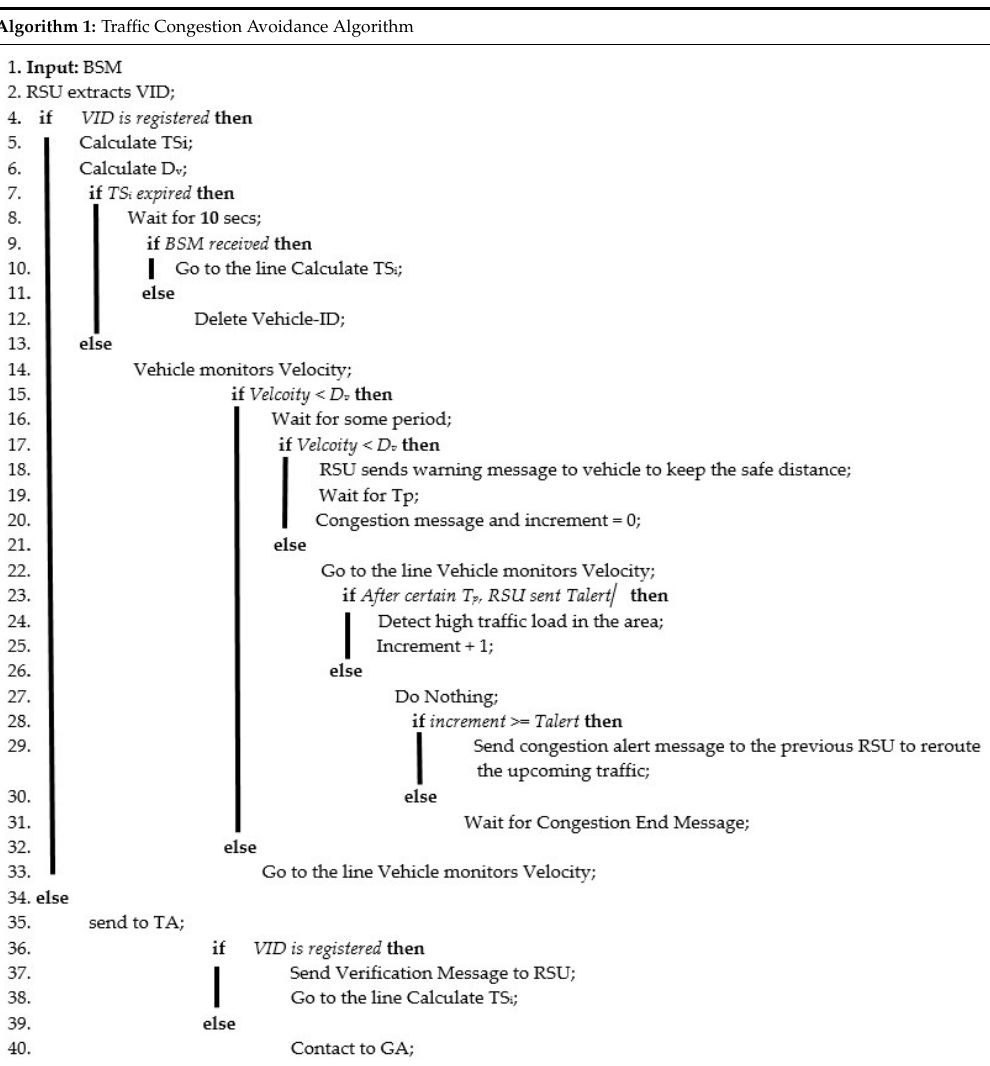
Algorithm 1: Traffic Congestion Avoidance